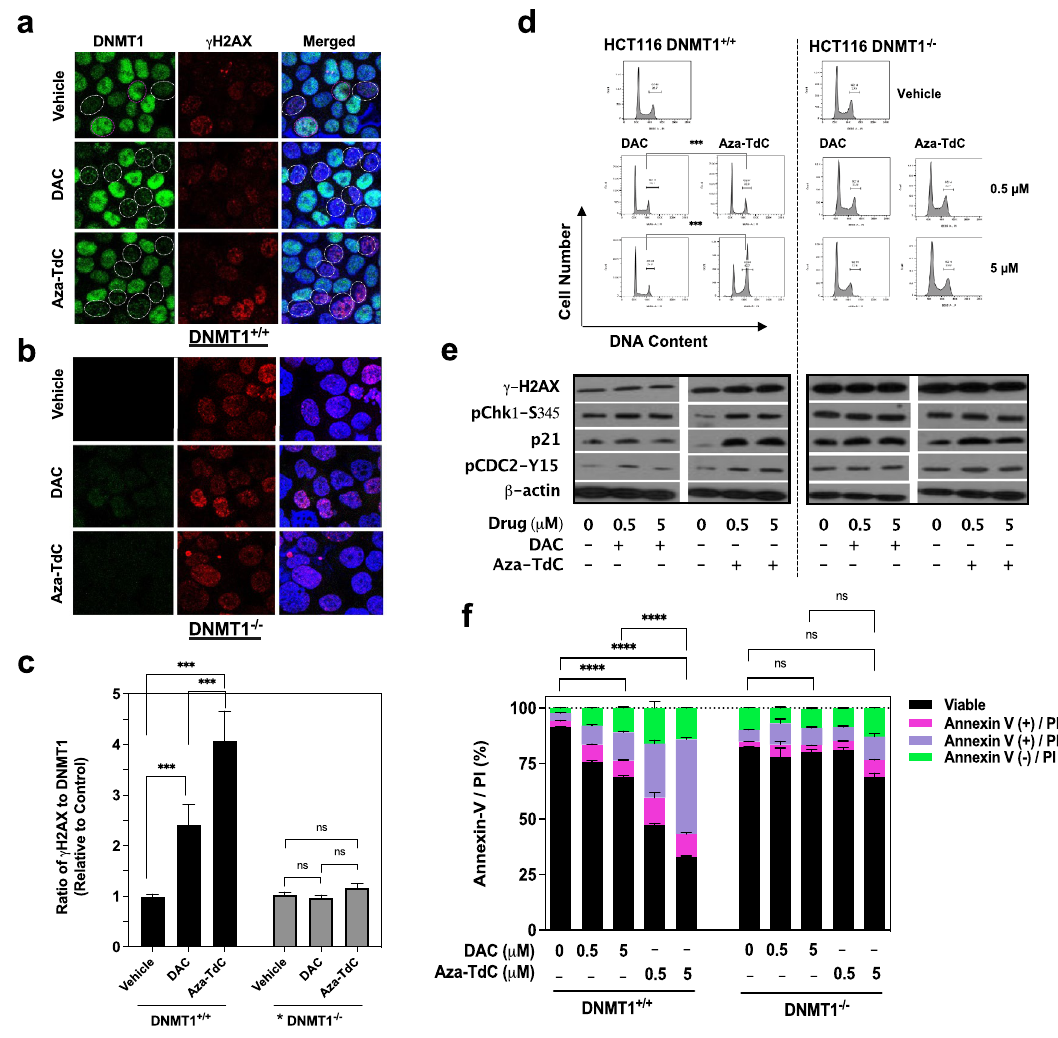
Figure 2. Effects of DNMTi on DNMT1 and DNA damage, cell-cycle, and apoptosis in HCT116 cells. ( a ) Confocal microscopy showing inhibition of DNMT1 (green fluorescence, white circles) and induction of γH2AX (red fluorescence) upon exposure to 5 µM of DAC and aza-TdC at 30 min in DNMT1 +/+ nuclei (merged, white circles); intrinsic γH2AX and DNMT1 in vehicle-treated DNMT1 +/+ cells (white and purple circles). ( b ) DNMT1 and γH2AX in DNMT1 −/− cells. ( c ) Ratio of γH2AX to DNMT1 intensity by DAC and aza-TdC. *Low level of DNMT1 expression was detected in DNMT1 −/− cells. ( d ) Cell-cycle distribution after exposure to DAC and aza-TdC for 24 h. ( e ) Activation of the cell-cycle checkpoint effectors by DAC and aza-TdC. ( f ) Induction of early apoptosis (annexin+/PI−), late apoptosis (annexin+/PI+) and cell death (annexin−/PI+) upon exposure to DAC and aza-TdC for 96 h. All samples in the cell-cycle and apoptosis experiments were assayed in triplicate, with at least three independent experiments performed, and data were shown as mean ± SD. *** P < 0.001; **** P < 0.0001; ns not significant. PI propidium iodide. One representative experiment is shown from at least three independent experiments for other